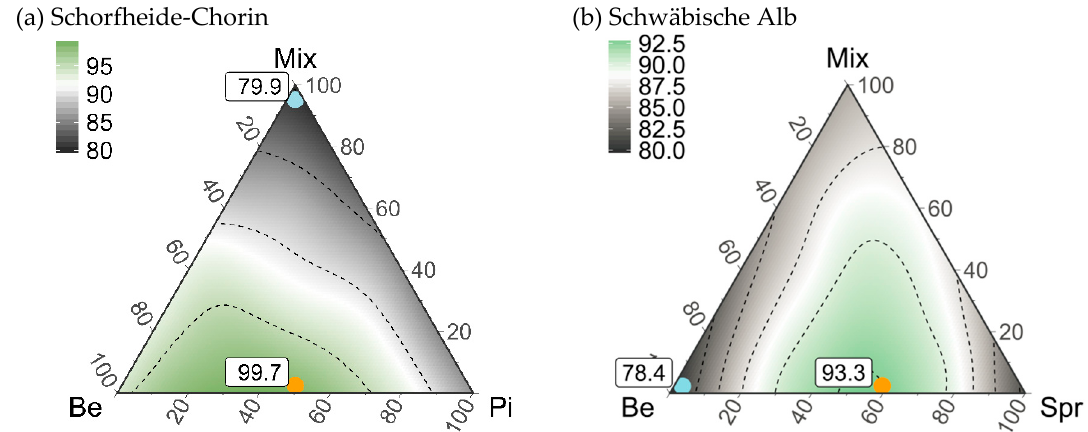
Figure 7. Regional diversity (species richness) in % for ( a ) Schorfheide-Chorin and ( b ) Schwäbische Alb combining vascular plants, bryophytes and lichens along compositional gradients of pure beech (Be), pure conifer (Pi = Pine, Spr = Spruce) and mixed stands (Mix). The stand type composition was varied in steps of 10% using 1000 resamplings of 22 plots per step for Schorfheide-Chroin and using 66 resamplings of 10 plots per step for Schwäbische Alb. The regional diversity quantifies the mean relative gamma diversity of taxonomic groups accounting for the absolute diversity within groups (log weighting of diversity). Labelled dots mark the maximum (orange) and minimum (light blue) regional diversity.